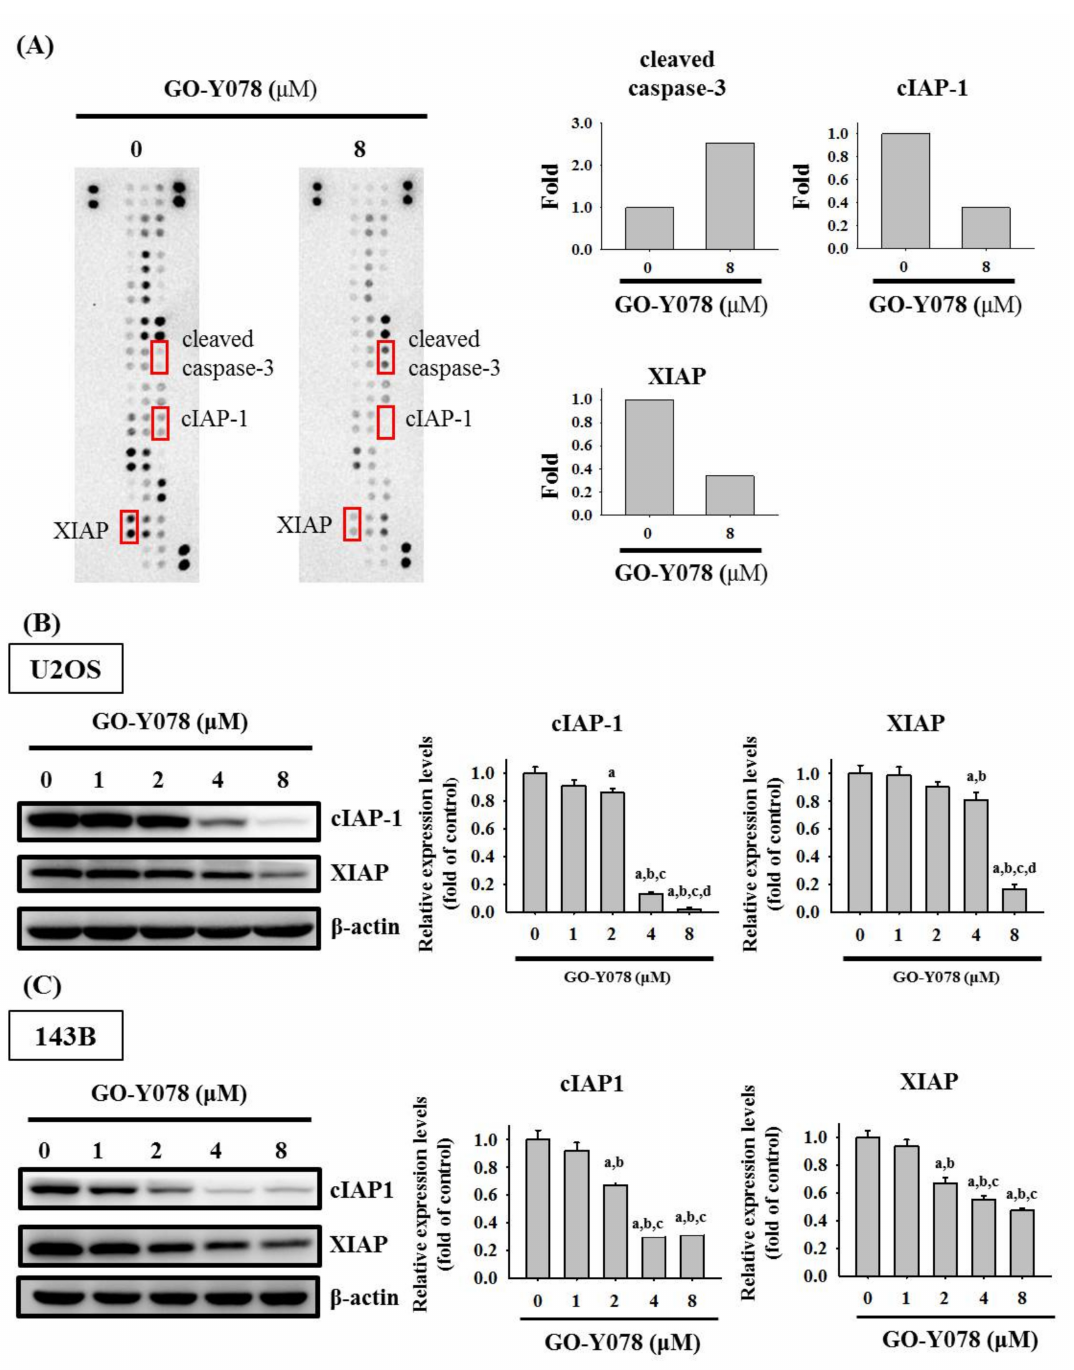
Figure 4. Effects of GO-Y078 on the human apoptosis array and IAPs in U2OS and 143B cells. ( A ) After treatment of 8 µ M GO-Y078 for 24 h in U2OS cells, the human apoptosis array, 35 apoptosis-related proteins included, were employed as described in the Materials and Methods section and the increased protein cleaved caspase-3 and decreased proteins cIAP-1 and XIAP were subjected to quantitative analysis. Western blot analysis for cIAP-1 and XIAP after various concentrations (1, 2, 4, and 8 µ M) of GO-Y078 treatment for 24 h in ( B ) U2OS and ( C ) 143B cells were measured as described in the Materials and Methods section. Subsequently, expressions of cIAP-1 and XIAP were subjected to quantitative analysis. Results are shown as mean ± S.D.; n = 3. ANOVA analysis with Tukey’s posteriori comparison was used. U2OS: cIAP-1: F = 611.988, p < 0.001; XIAP: F = 137.150, p < 0.001. 143B: cIAP-1: F = 178.003, p < 0.001; XIAP: F = 115.677, p < 0.001. a Significantly different, p < 0.05, when compared to control. b Significantly different, p < 0.05, when compared to 1 µ M. c Significantly different, p < 0.05, when compared to 2 µ M. d Significantly different, p < 0.05, when compared to 4 µ